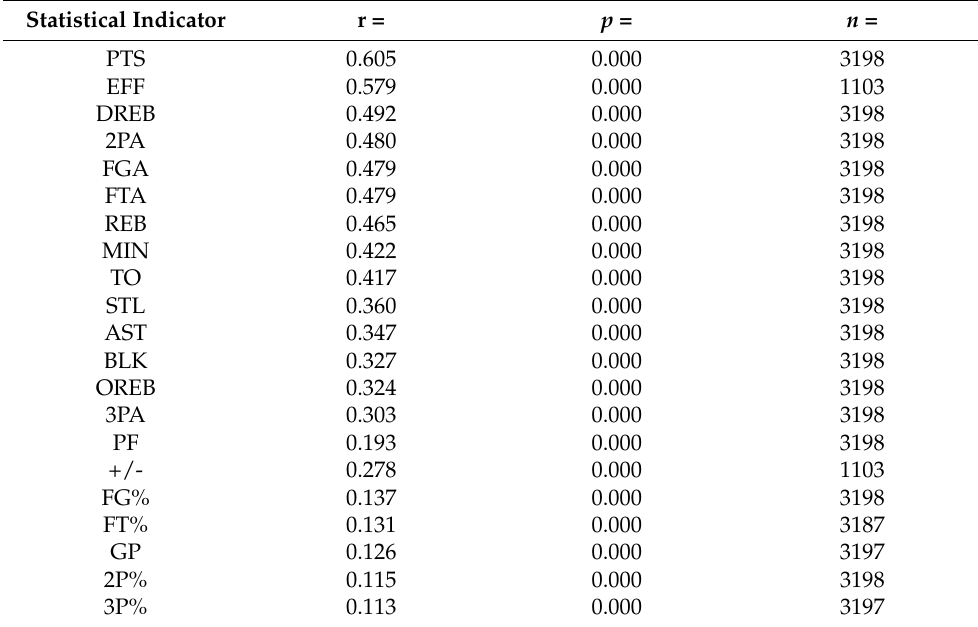
Table 2. Correlation of statistical indicators with selection to the all-star team (figure by the authors). Statistical